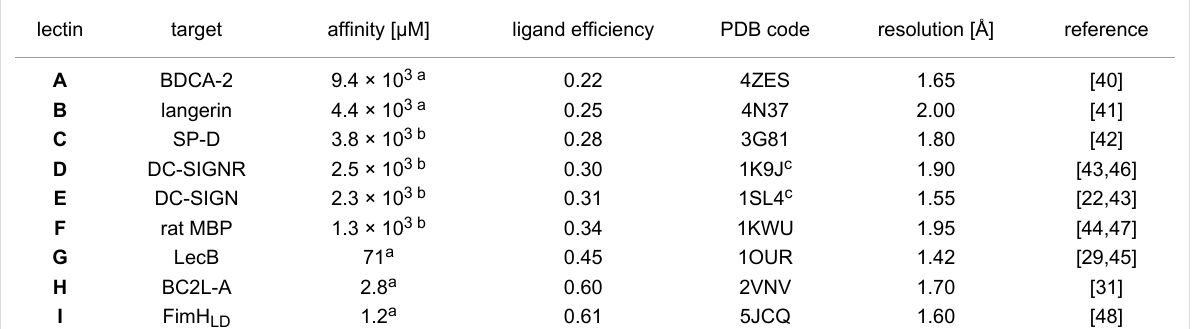
Table 1: Crystal structures of mannose-binding lectins, and their affinity for α -D-mannose ( 1 ) or methyl α -D-mannopyranoside ( 2 ). lectin